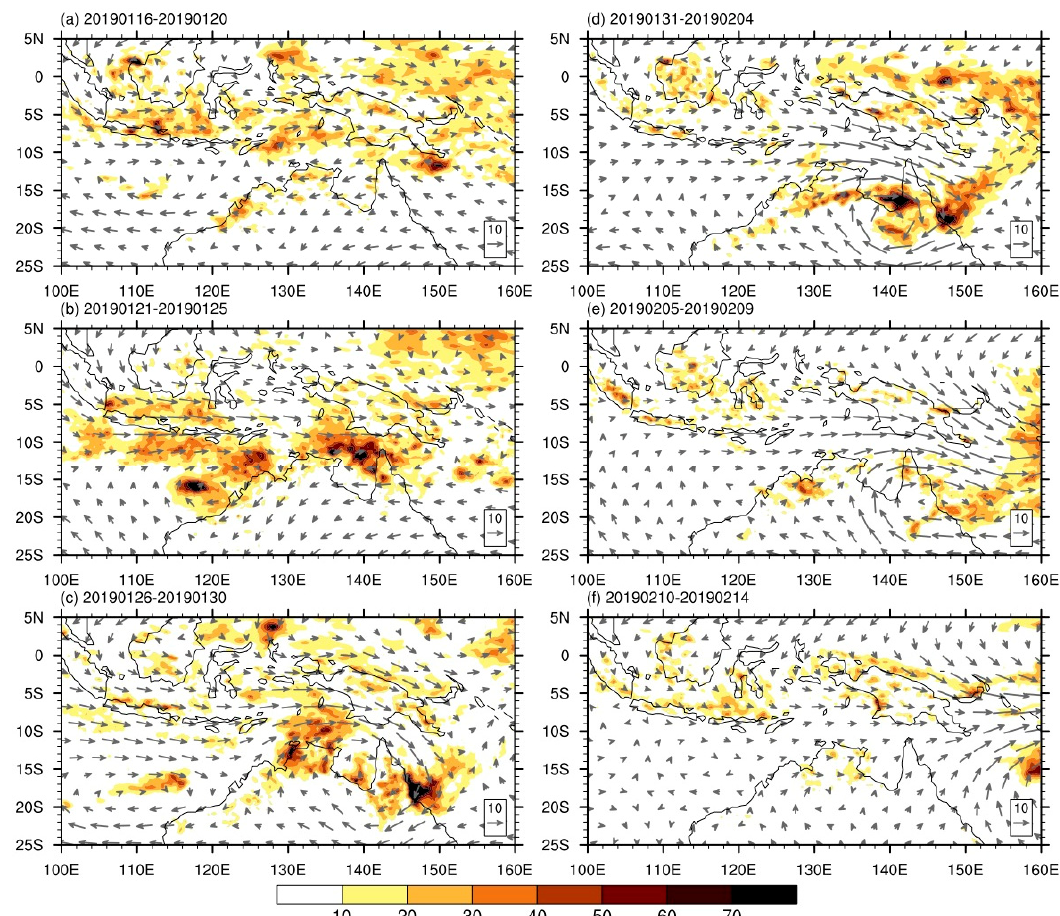
Figure 3. The pentad-mean CMORPH precipitation map (shading, unit: mm day − 1 ), 850-hPa wind field (vectors, unit: m s − 1 ), ( a – f ) for the pentads from 16–20 January (Pentad 4) to 10–14 February (Pentad 9) in 2019, which covers the period of 2018/19 SPRE over northeastern Queensland.